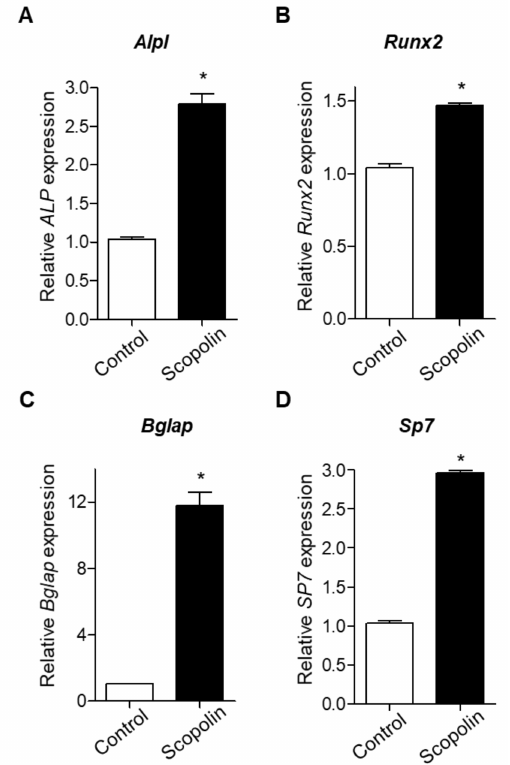
Figure 3. Scopolin treatment increased the mRNA levels of bone remodeling markers in MC3T3-E1 cells. The cells were treated with 5 µ M scopolin. The mRNA levels of Alpl (alkaline phosphatase, ALP) ( A ), Runx2 (runt-related transcription factor 2) ( B ), Bglap (bone gamma-carboxyglutamic acid-producing protein, osteocalcin) ( C ), and S p7 (osterix) ( D ) were calculated quantitatively using reverse-transcription PCR (RT-PCR) with targeted gene-specific primers. Control: Non-scopolin-treated MC3T3-E1 cells. * p < 0.05 vs. Control. The measurements of mRNA expression levels were repeated three